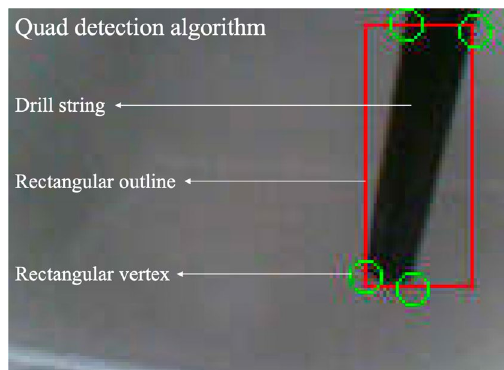
Fig. 16 Line segment detection